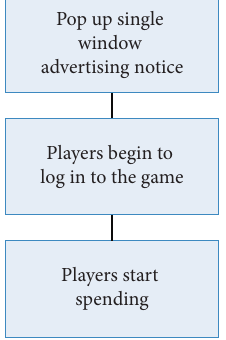
Figure 1: Free game marketing model process.